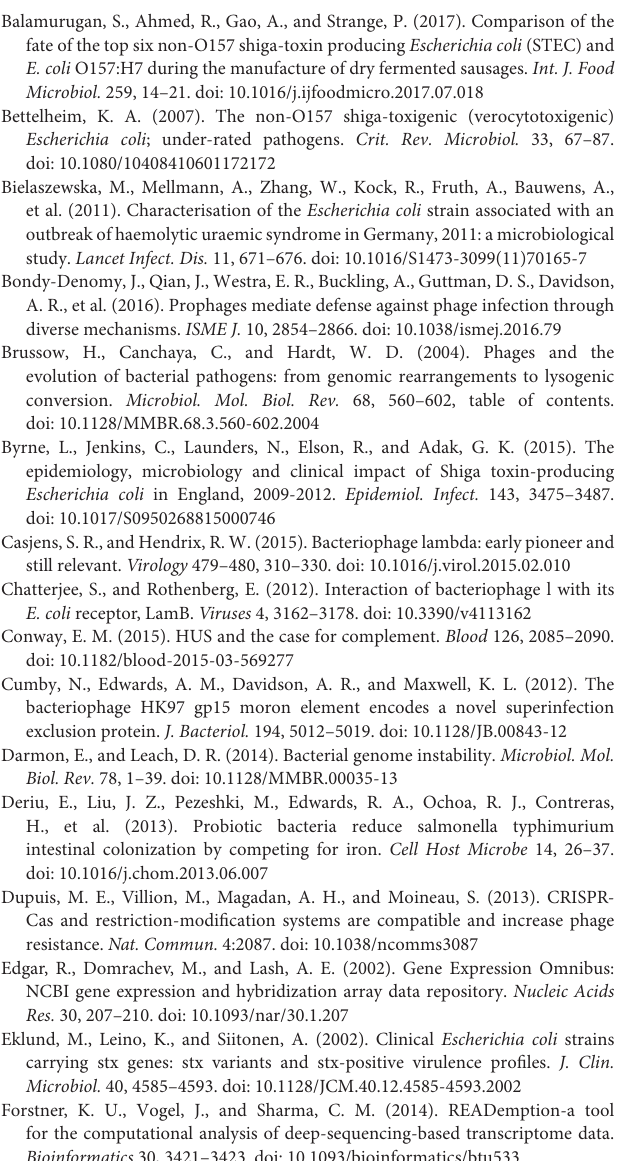
(B) stx -phages (1:100) with or without SK22D or the commensal E. coli strains SE15 and IAI1 (MG1655: SK22D/commensals: 1:1). The CFUs of MG1655 were determined after a 24 h incubation period on ECC plates. ∗∗∗ p < 0.001, ∗∗∗∗ p < 0.0001. Table S1 | Table describing the prophages predicted in EcN by PHAST. Prophage 3 that is shown in this study to contribute for the superinfection immunity of EcN against lambdoid prophages. Table S2 | Presence of EcN’s lambdoid prophage genes in the commensal strains SE15 and IAI1 and the K-12 strain MG1655. − , gene not present; + , gene present outside of a lambdoid prophage; P, gene encoded on a lambdoid prophage; ∗ Sequence not identical to EcN’s lambdoid